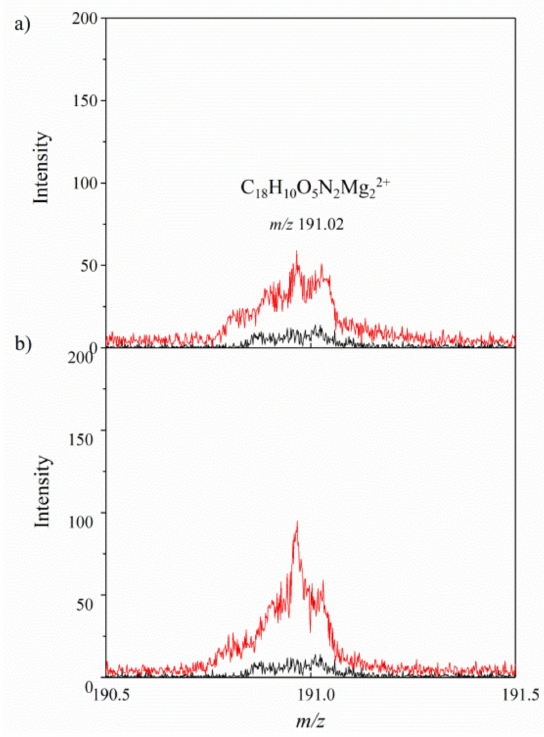
Figure 1. Positive secondary ion mass spectrometry TOF-SIMS spectra for aluminum–magnesium hydroxycarbonate AlMg − LH (black line) and AlMg − LH /AD 10% (red line) ( a ) and AlMg − LH (black line) and AlMg − LH /AD 20% (red line) ( b )